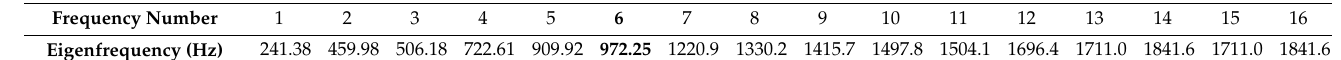
Figure 6. A mesh model of the Y25 bogie with insulation prepared in the COMSOL Multiphysics program. Table 1. Calculated eigenfrequencies of freight wagon bogie type